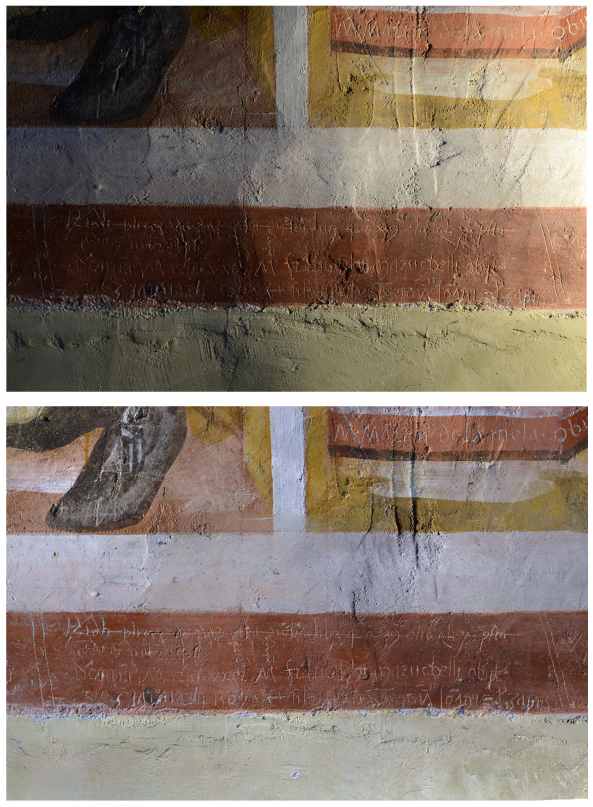
Figure 8. Improved readability: traditional light setting (left) vs. orthophoto